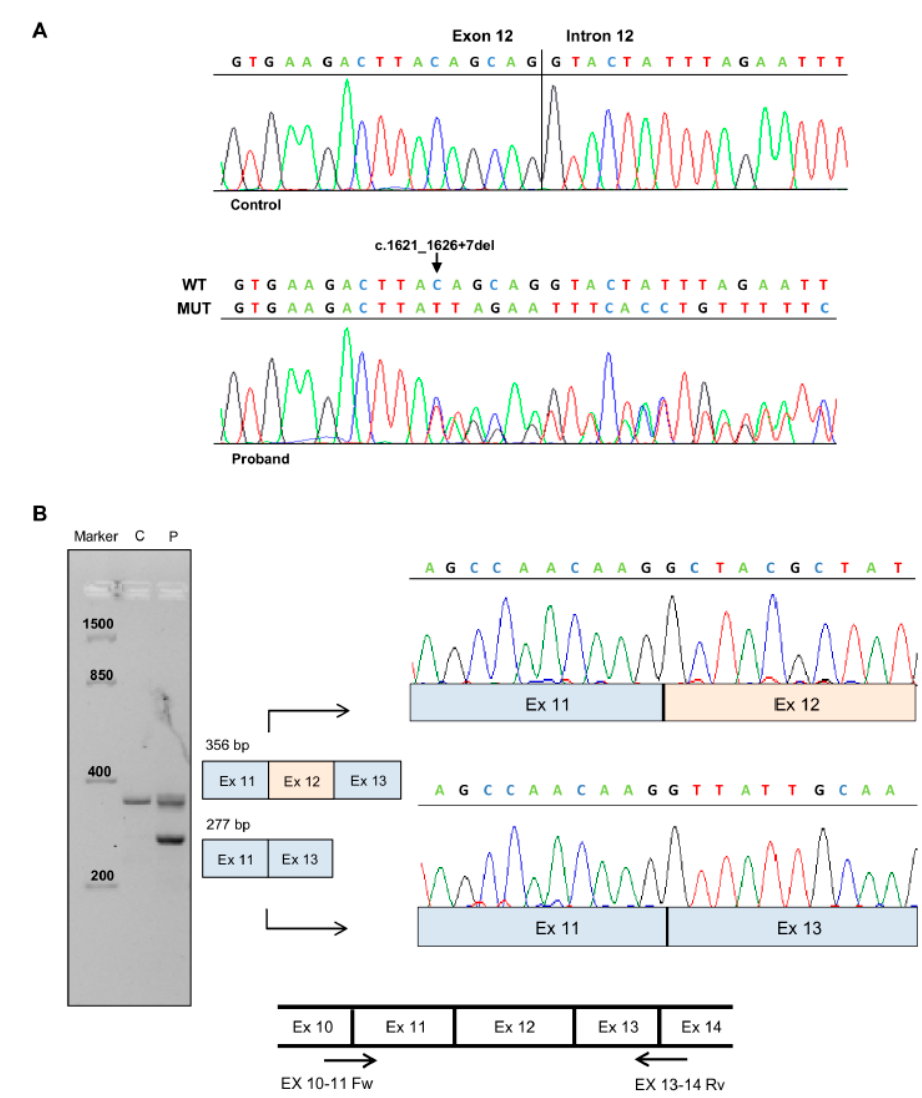
Figure 2. Characterization of APC splicing mutation c.1626_1627+7del. ( A ) Sequencing electropherograms of genomic DNA from a healthy control individual and the proband, showing the splicing mutation c.1626_1627+7del. ( B ) Left: Agarose gel electrophoresis showing the RT-PCR analysis of mRNA extracted from peripheral blood of the patient (P) carrying the APC c.1621_1626+7del mutation and a healthy control (C). Amplified products obtained with primers spanning APC exon 10–11 and 13–14 boundaries were separated on 3% agarose gel and independently sequenced. Center: Schematic diagrams showing the wild type amplification product (356 bp) and the altered-splicing amplification product lacking APC exon 12 (277 bp). Right: Sequencing electropherograms of cDNA splicing isoforms generated from the wild type and mutant RT-PCR products. Bottom: Diagram showing the localization of the primers (indicated as arrows) used for RT-PCR experiments.